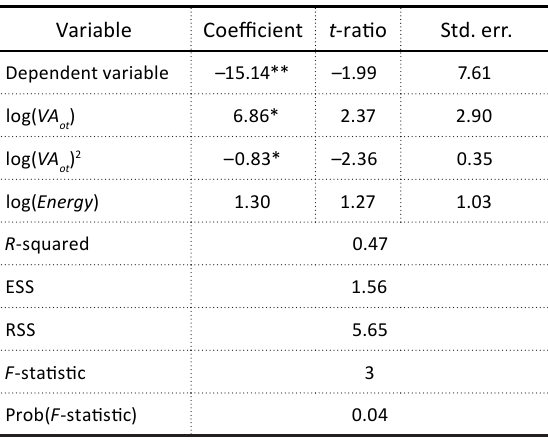
Table 3. Regression results